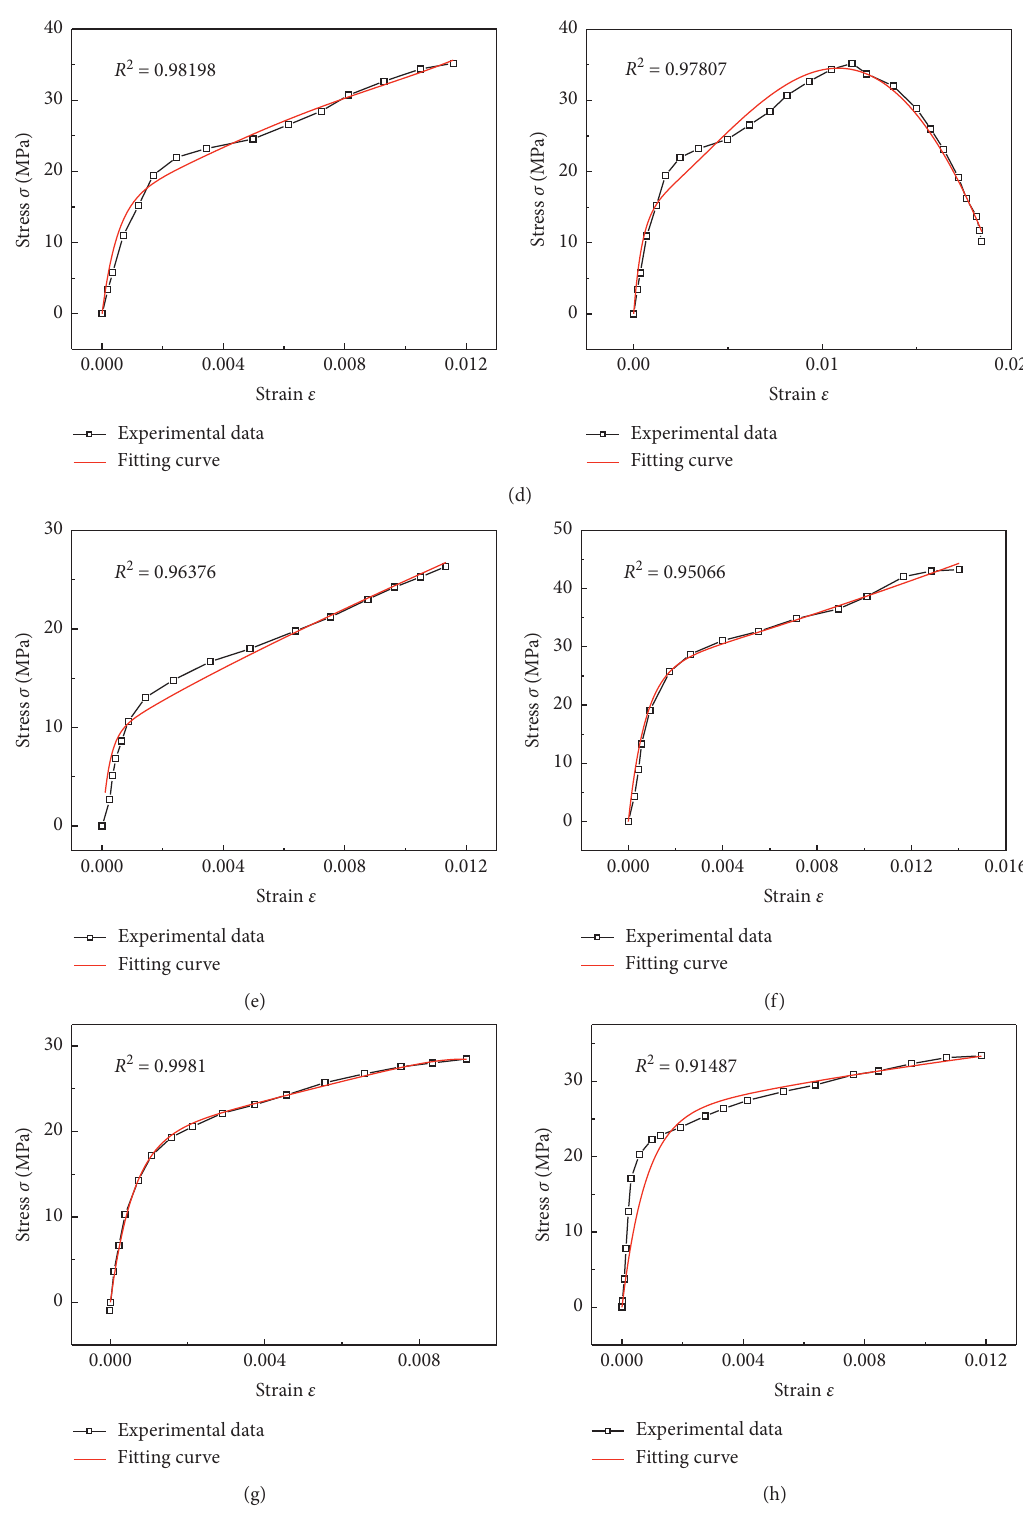
Figure 7: Dynamic stress-strain curve fitting of sandstone at different temperatures: (a) T � 20 ° C and _ ε � 105 . 89s − 1 ; (b) T � 20 ° C and _ ε � 154 . 88s − 1 ; (c) T � − 10 ° C and _ ε � 138 . 5s − 1 ; (d) T �− 10 ° C and _ ε � 210s − 1 ; (e) T �− 20 ° C and _ ε � 135 . 48s − 1 ; (f) T �− 20 ° C and _ ε � 224 . 15s − 1 ; (g) T �− 30 ° C and _ ε � 158 . 02s − 1 ; (h) T � − 30 ° C and _ ε � 189 . 21s − 1